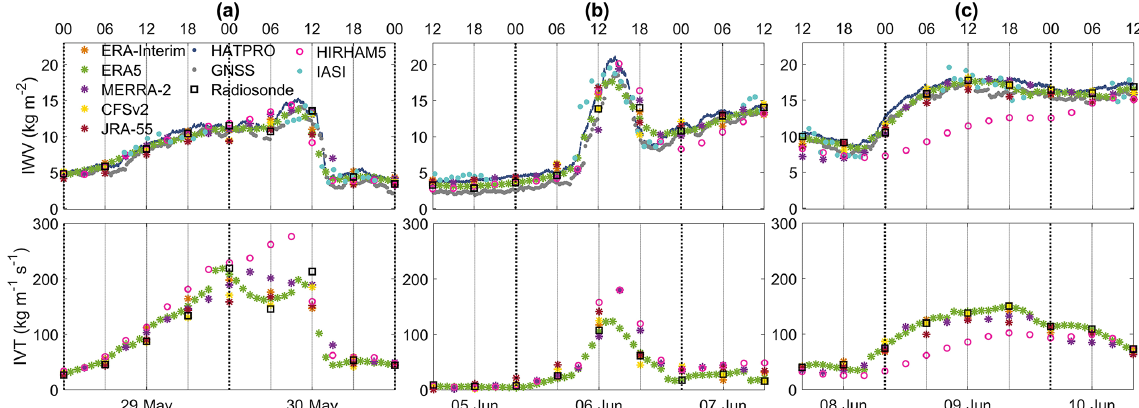
Figure 5. Time series of integrated water vapour (IWV, kgm − 2 , top row) and integrated vapour transport (IVT intensity, kgm − 1 s − 1 , bottom row), based on reanalyses (ERA-Interim, ERA5, MERRA-2, CFSv2, and JRA-55), radiosonde, ground-based remote sensing (HATPRO and GNSS) and satellite measurements (IASI), and the HIRHAM5 model, at Ny-Ålesund during the 30 May event (a) , the 6 June event (b) , and the 9 June event (c)